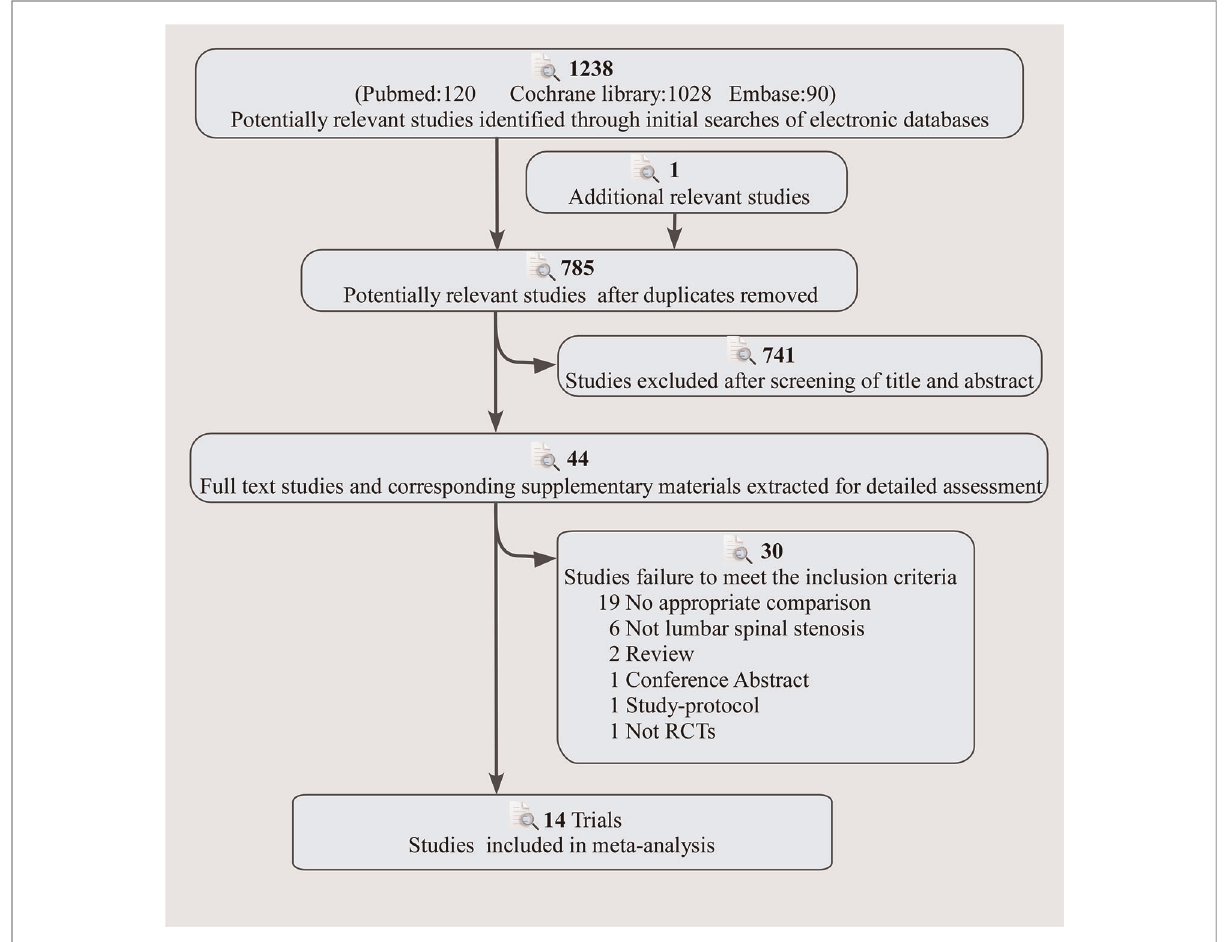
FIGURE 1 Literature search and screening